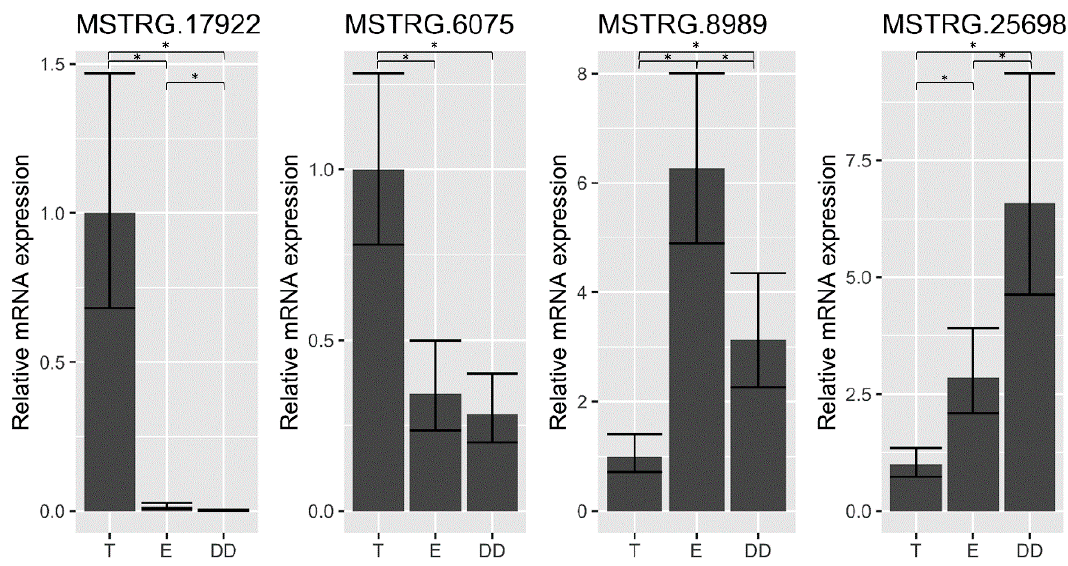
Figure 8. The real-time PCR results. The statistical significance of the expression differences was confirmed at the level <0.05 and is marked with a star. Data are shown as mean values ± SD.